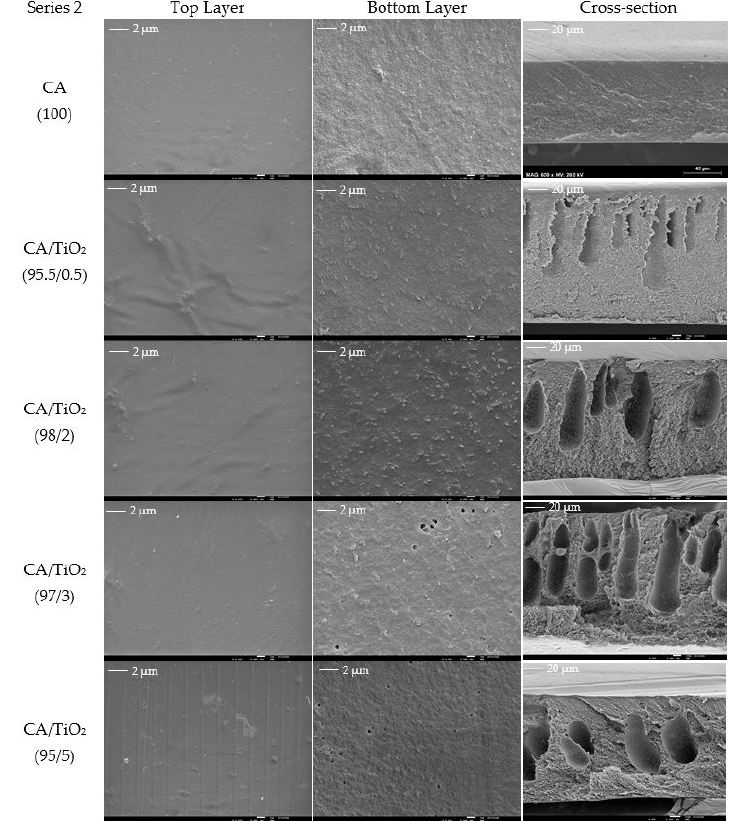
Figure 3. Field emission gun (FEG)-SEM images of the top surface (magnification 5000 × ), bottom surface (magnification between 550 × and 650 × ) and cross-sections (magnification 5000 × ) of: ( a ) the membranes in series 1, and ( b ) the membranes in series 2.